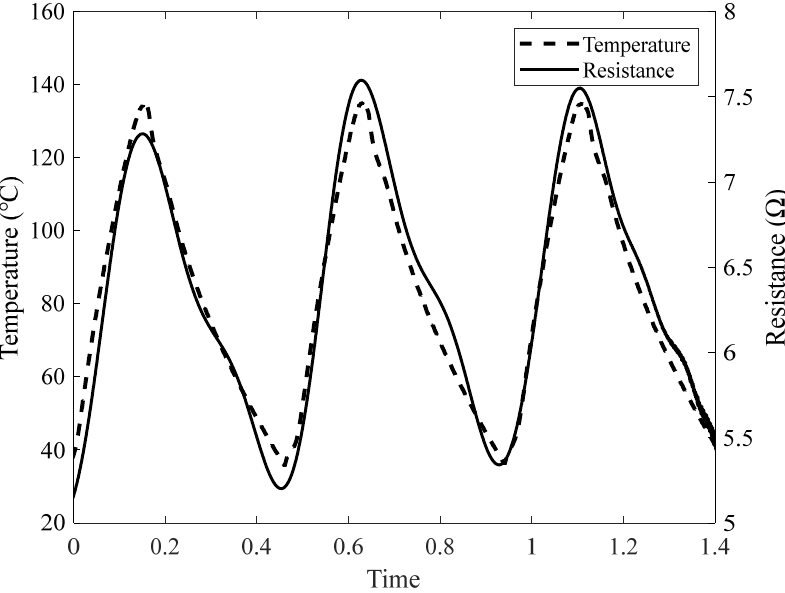
Figure 8. Temperature cycling results of the fabricated temperature sensor.